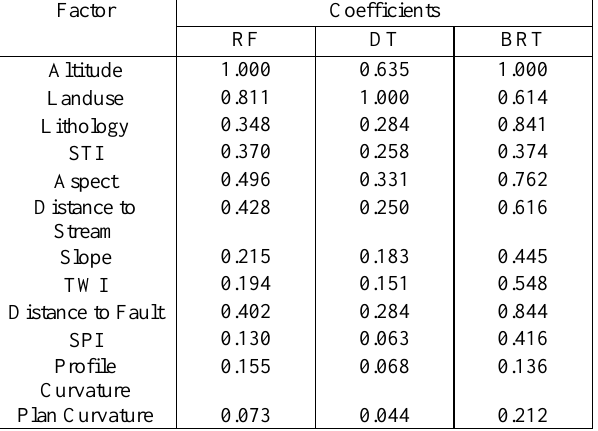
Table 3. Estimated coefficients of landslide conditioning factors by the RF, DT, and BRT.